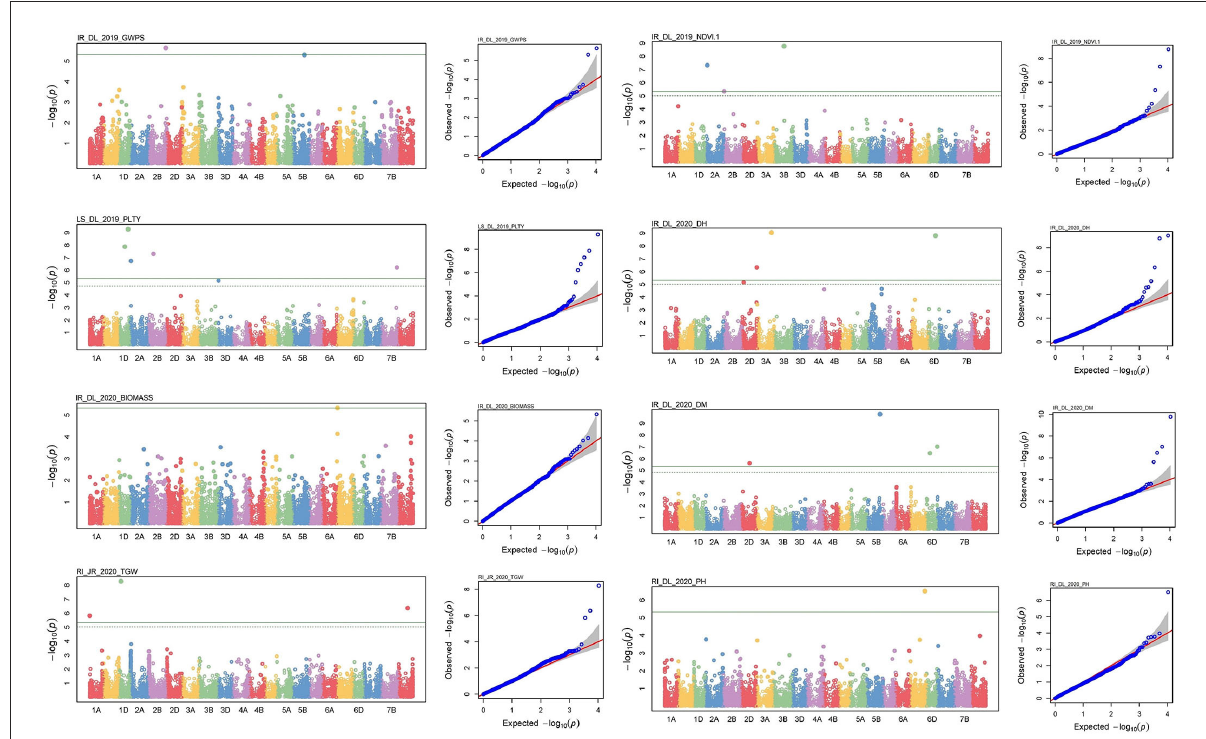
FIGURE7 Manhattan and respective-QQ plots of significant associations at IR_Delhi_2019 for GWPS, LS_DL_2019 for PLTY, IR_DL_2020 for BIOMASS and RI_JR_2020 for TGW, IR_DL_2019 for NDVI, IR_DL_2020 for DH, IR_DL_2020 for DM and IR_DL_2020 for